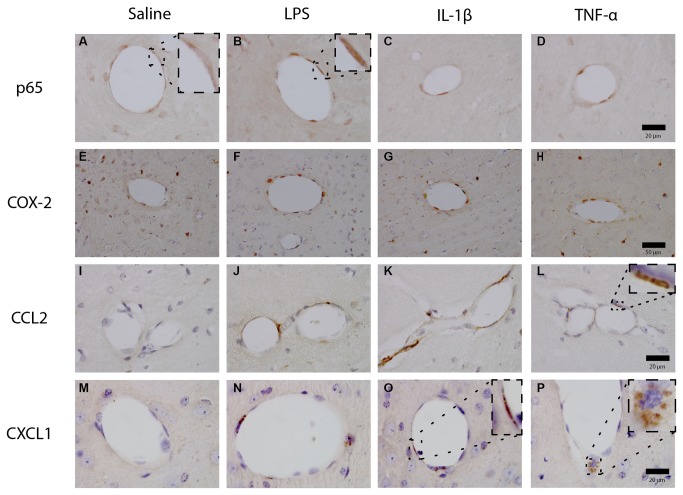
Expression of pro-inflammatory mediators at the brain vasculature following peripheral immune challenge.Representative micrographs of vascular NFκB p65, COX-2, CCL2 and CXCL1 2h after i.p. challenge with either saline, LPS (100µg/kg), IL-1β (15µg/kg) or TNF-α (50µg/kg). All pictures were taken from the hippocampus, except for COX-2, which were taken from the thalamus since neuropil labelling with COX-2 is also high in the hippocampus, thus reducing the contrast with activated endothelium. Scale bars are 20µm and 50µm as shown.